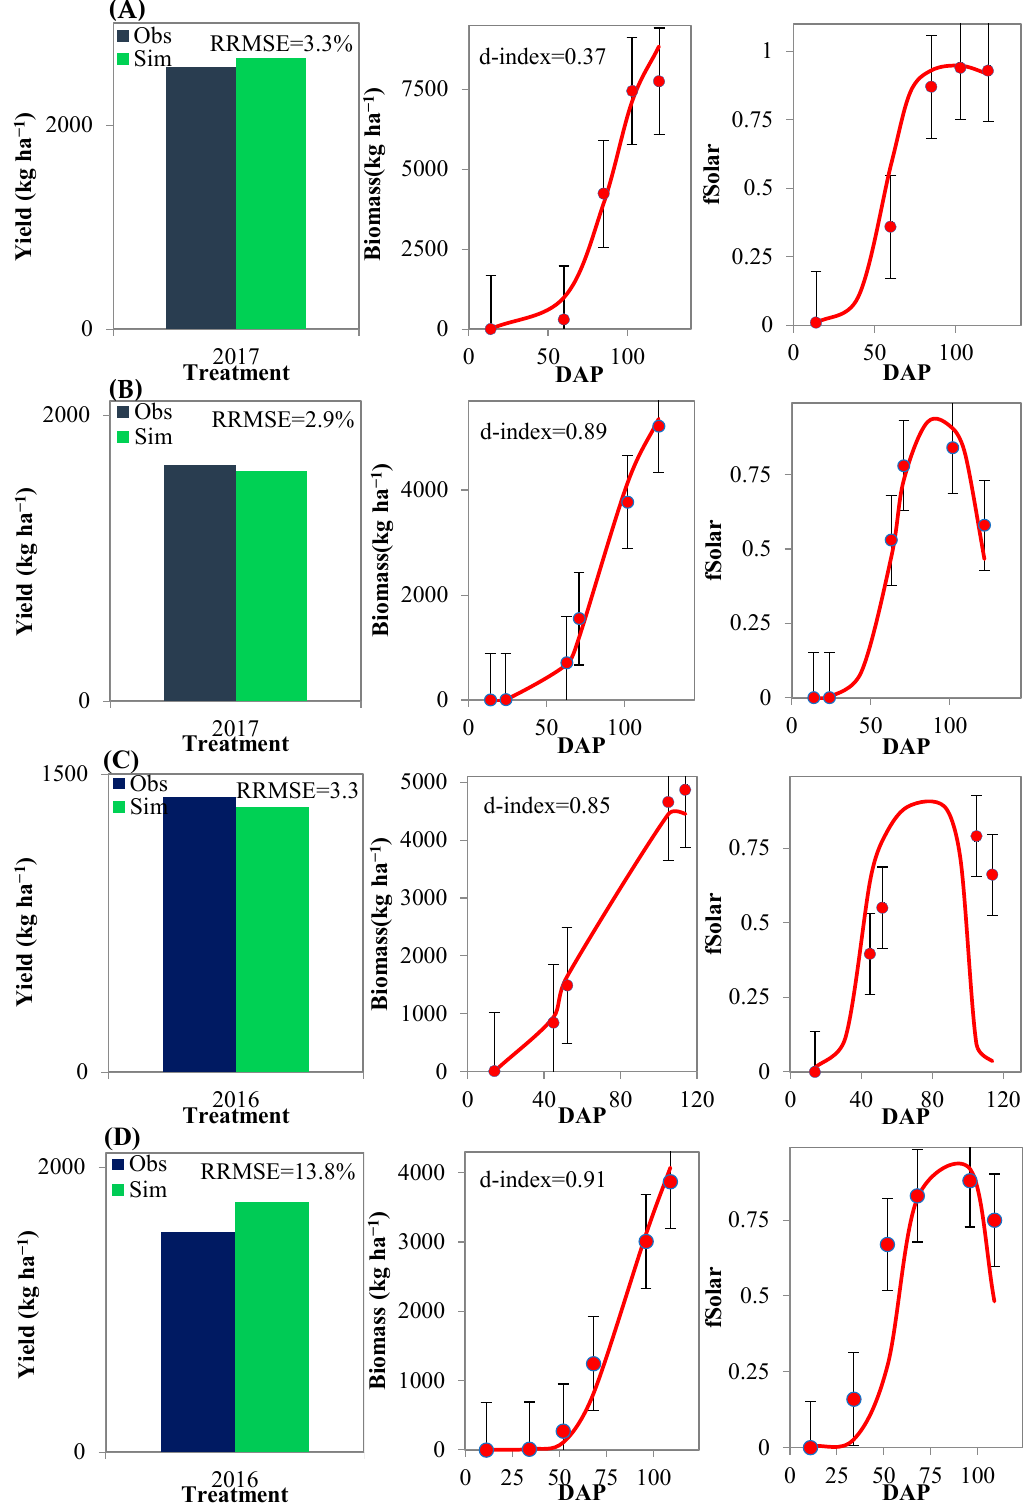
Figure 2. Calibration of simulated (Sim) and observed (Obs) yield, biomass, and fSolar as a function of DAP for oilseed flax cultivar Longya Hybrid No. 1 grown in Dingxi ( A ); Baxuan No. 3 grown in Zhangjiakou ( B ); Longya Hybrid No. 1 grown in Wulanchabu ( C ); and Zhangya No. 2 grown in Datong ( D ). RRMSE—relative root mean